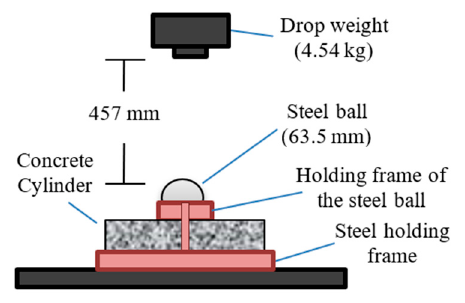
Figure 4. Illustration of the ACI 544-2R repeated impact apparatus.